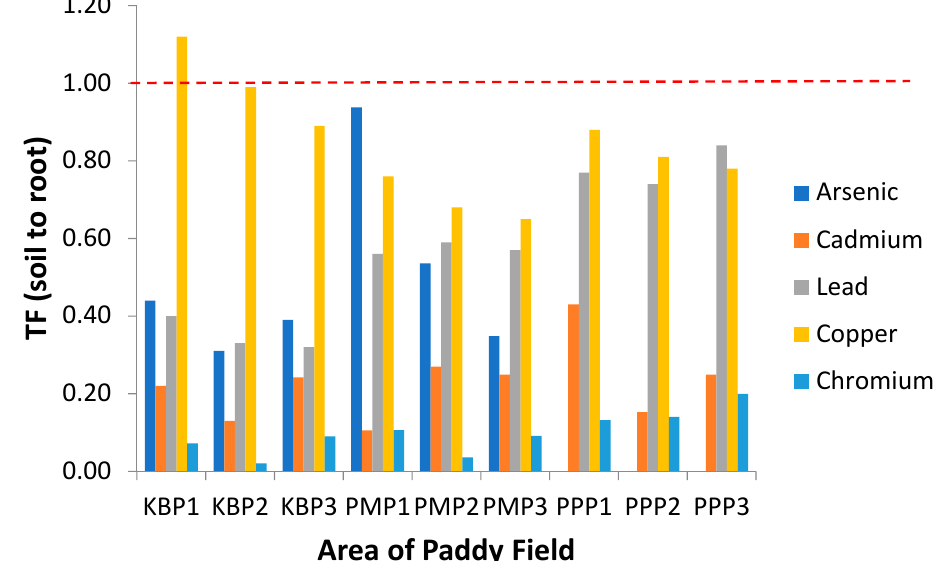
Figure 4. Translocation factor of the heavy metals from soil to root (TF Soil ) at different sampling sites. KBP1: Kota Bharu Plot 1, KBP2: Kota Bharu Plot 2, KBP3: Kota Bharu Plot 3, PMP1: Pasir Mas Plot 1, PMP2: Pasir Mas Plot 2, PMP3: Pasir Mas Plot 3, PPP1: Pasir Puteh Plot 1, PPP2: Pasir Puteh Plot 2, and PPP3: Pasir Puteh Plot 3.